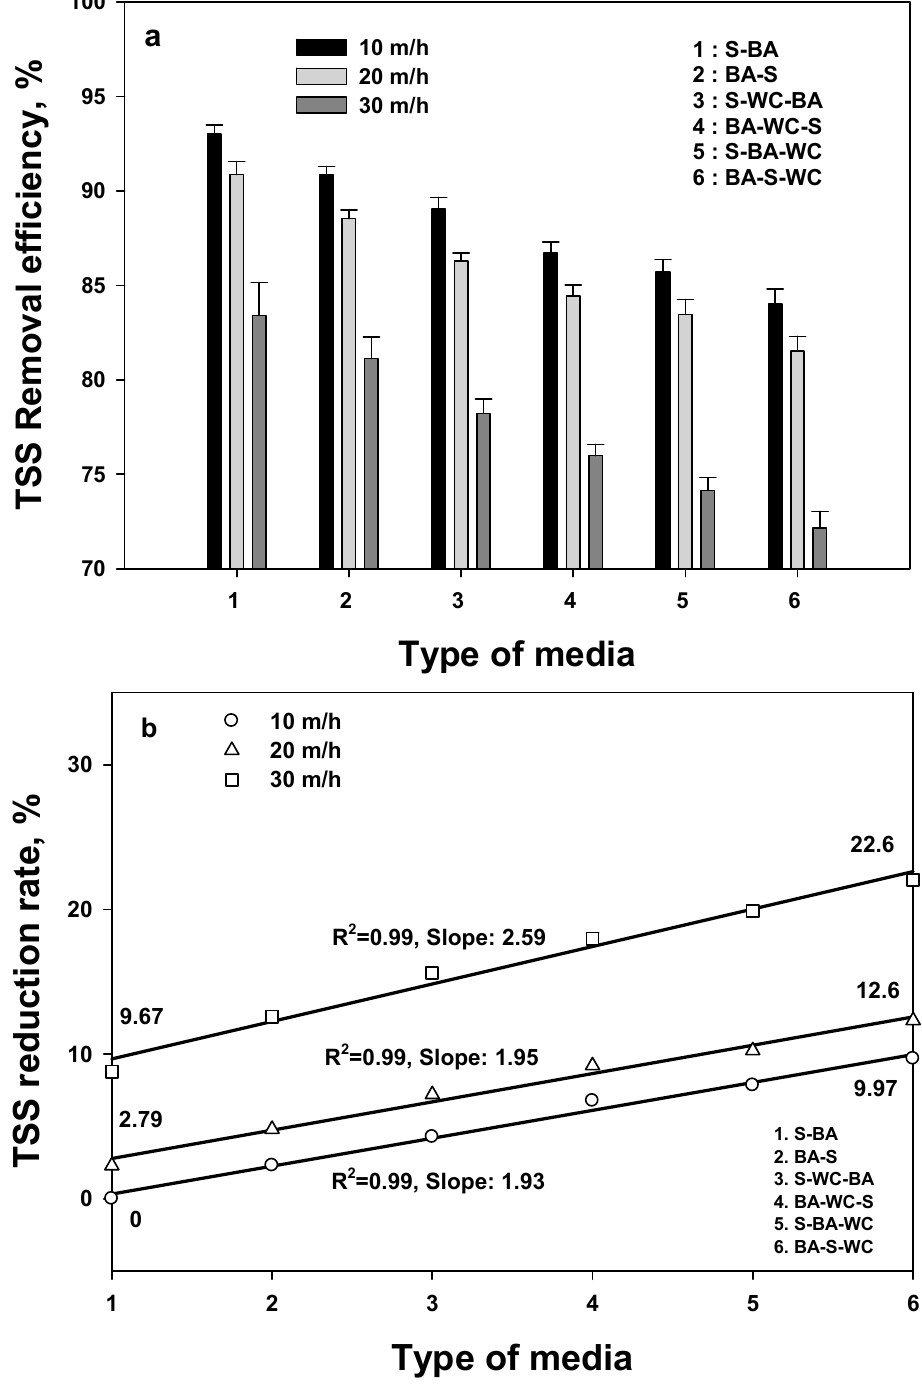
Figure 2. Total suspended solids’ (TSS) removal efficiencies (%): ( a ) TSS reduction rates (%) of TSS removal efficiency ( b ) for six media types and at three different hydraulic conductivities (HCs) (10, 20, and 30 m/h).